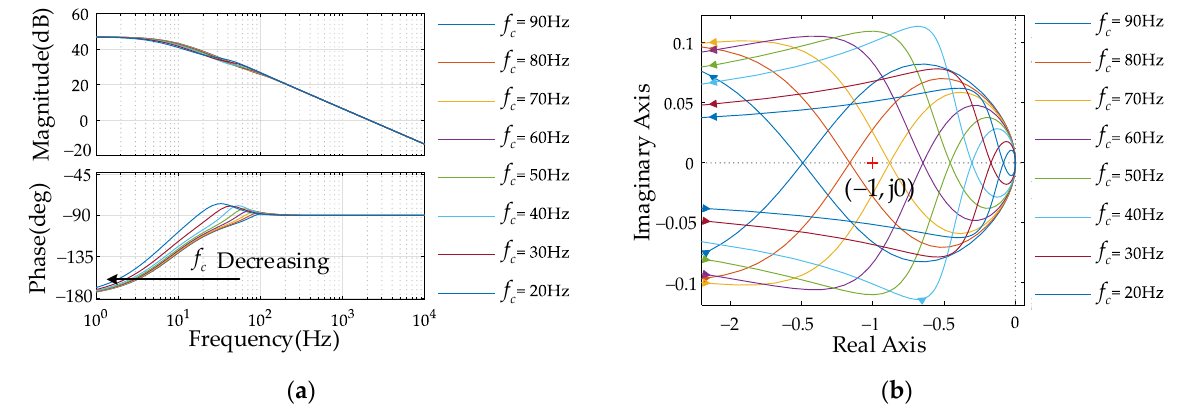
Figure 8. MVDC distribution system stability analysis with different cut-off frequencies: ( a ) Bode diagram of Z L ( s ) , ( b ) Nyquist diagram of T m .